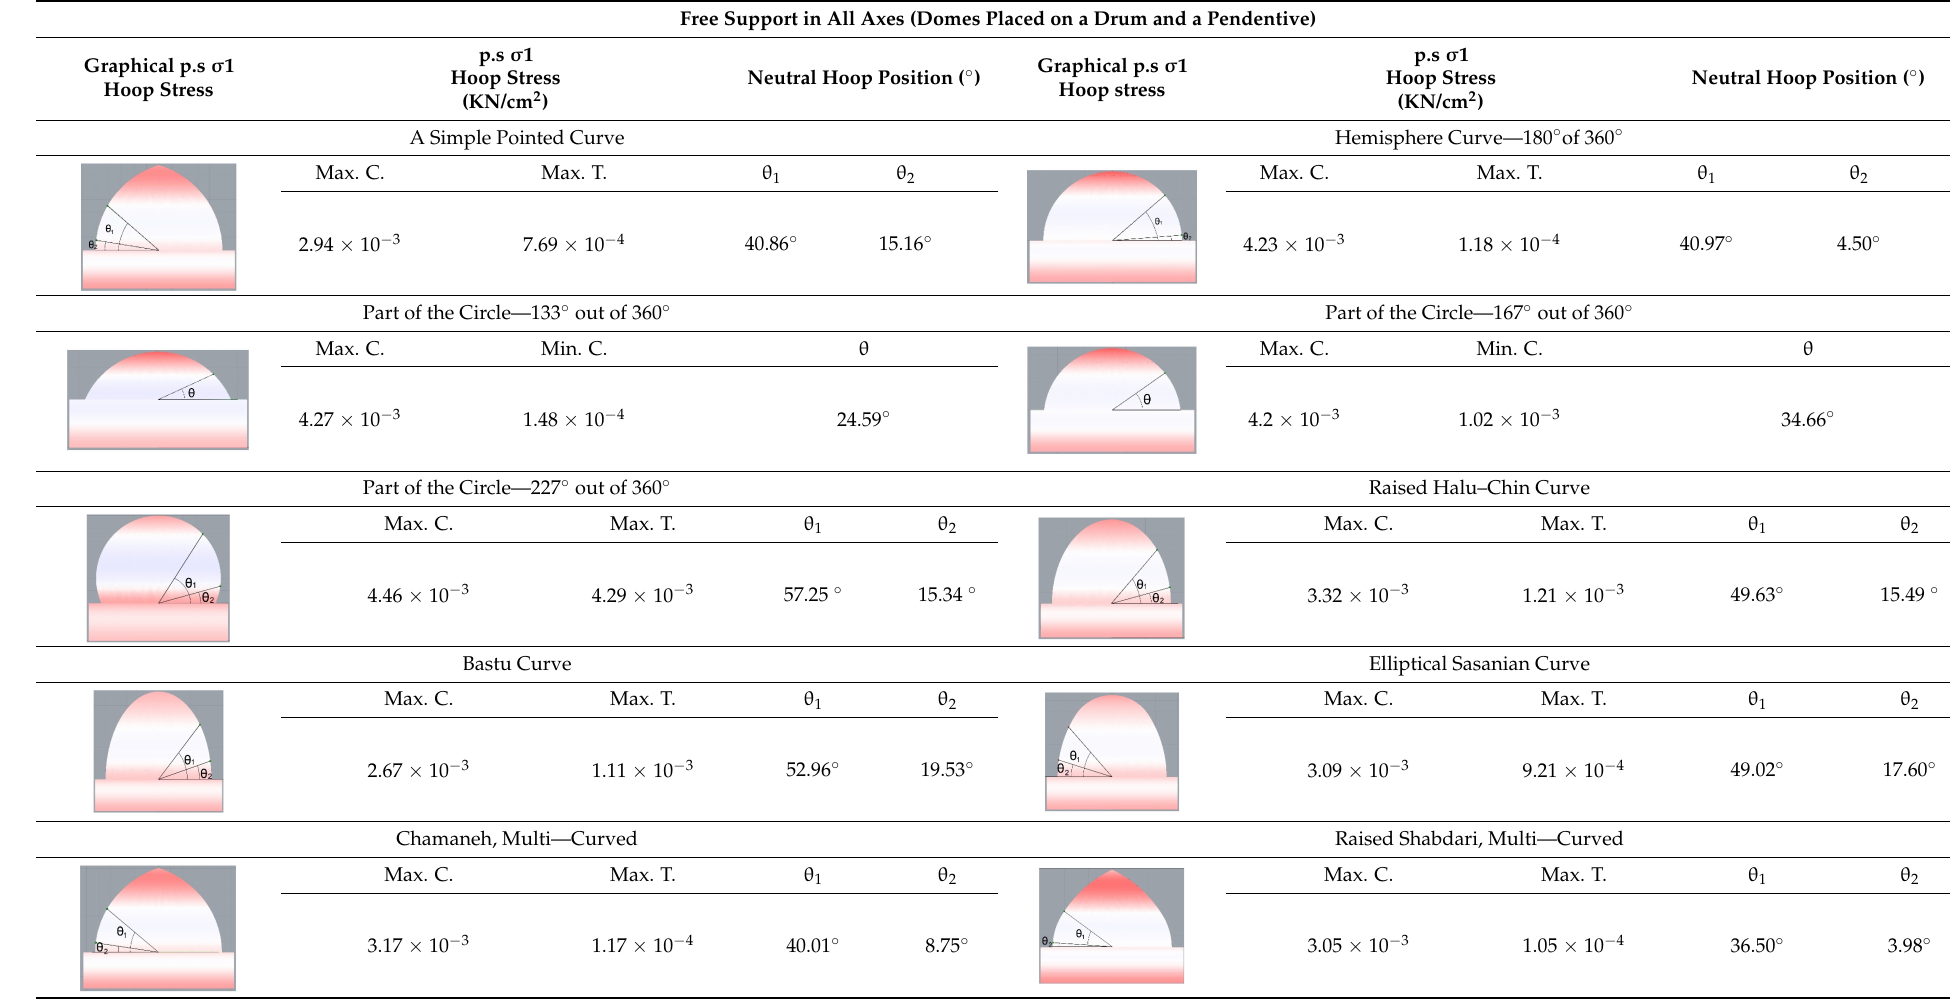
Table 10. Analysis of domes—R m = 5 m, t dome = 90 cm, t dome /d m = 0.09, H drum = 3 m, t drum = 1.1 × t dome , R drum = 5 m, R drum with pendentive = 6